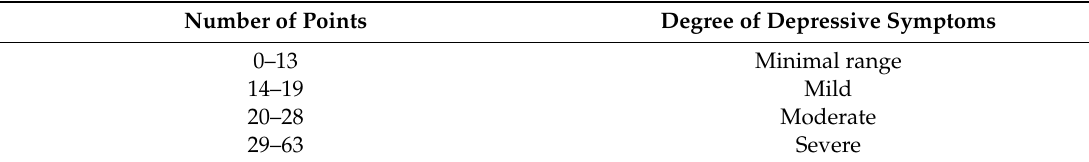
Table 1. Interpretation of the Beck Inventory (BDI-II) questionnaire results [25].